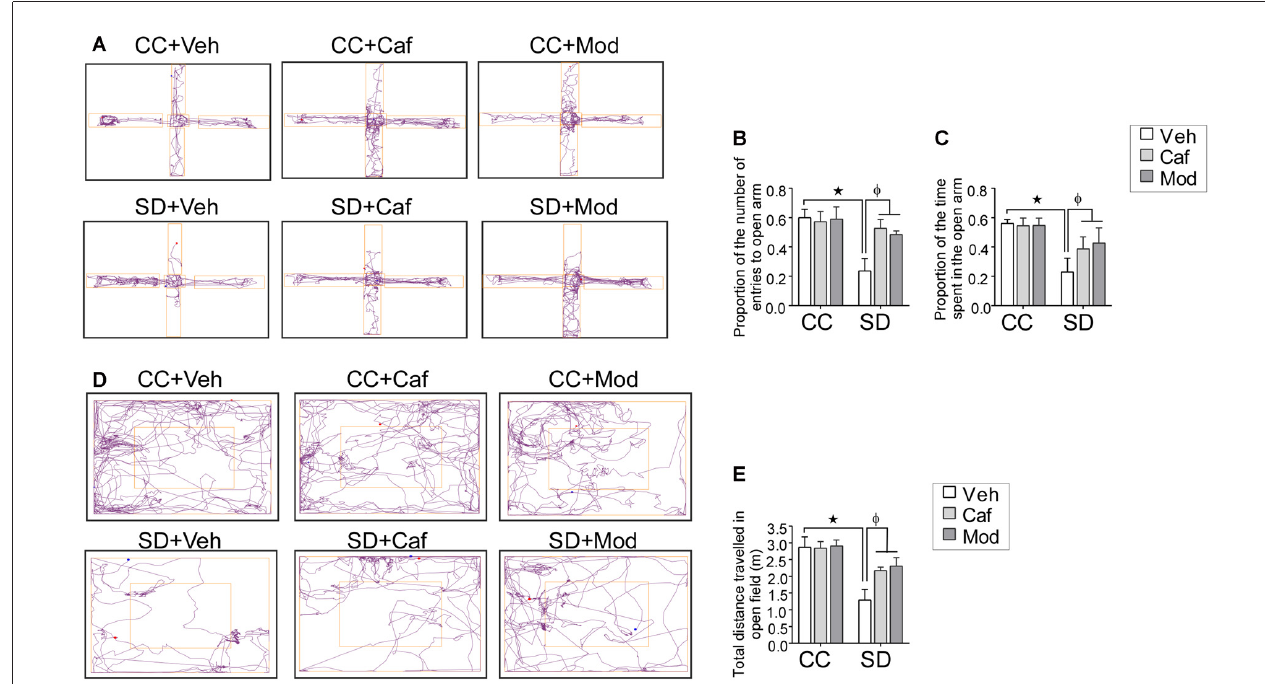
FIGURE 2 | Assessment of the anxious behavior following caffeine/modafinil treatment during sleep deprivation (SD). (A) Track plot of the rats during elevated plus maze (EPM) test and the study parameters: (B) proportion of the number of entries in the open arms; (C) proportion of the time spent in the open arms. (D) Track plot of the rats during open field (OF) test; (E) total distance traveled in the OF. ∗ p < 0.05 when compared to control treated with vehicle; φ p < 0.05 when compared to sleep deprived treated with vehicle. Two way ANOVA followed by Tukey post hoc test with multiple comparison was used.